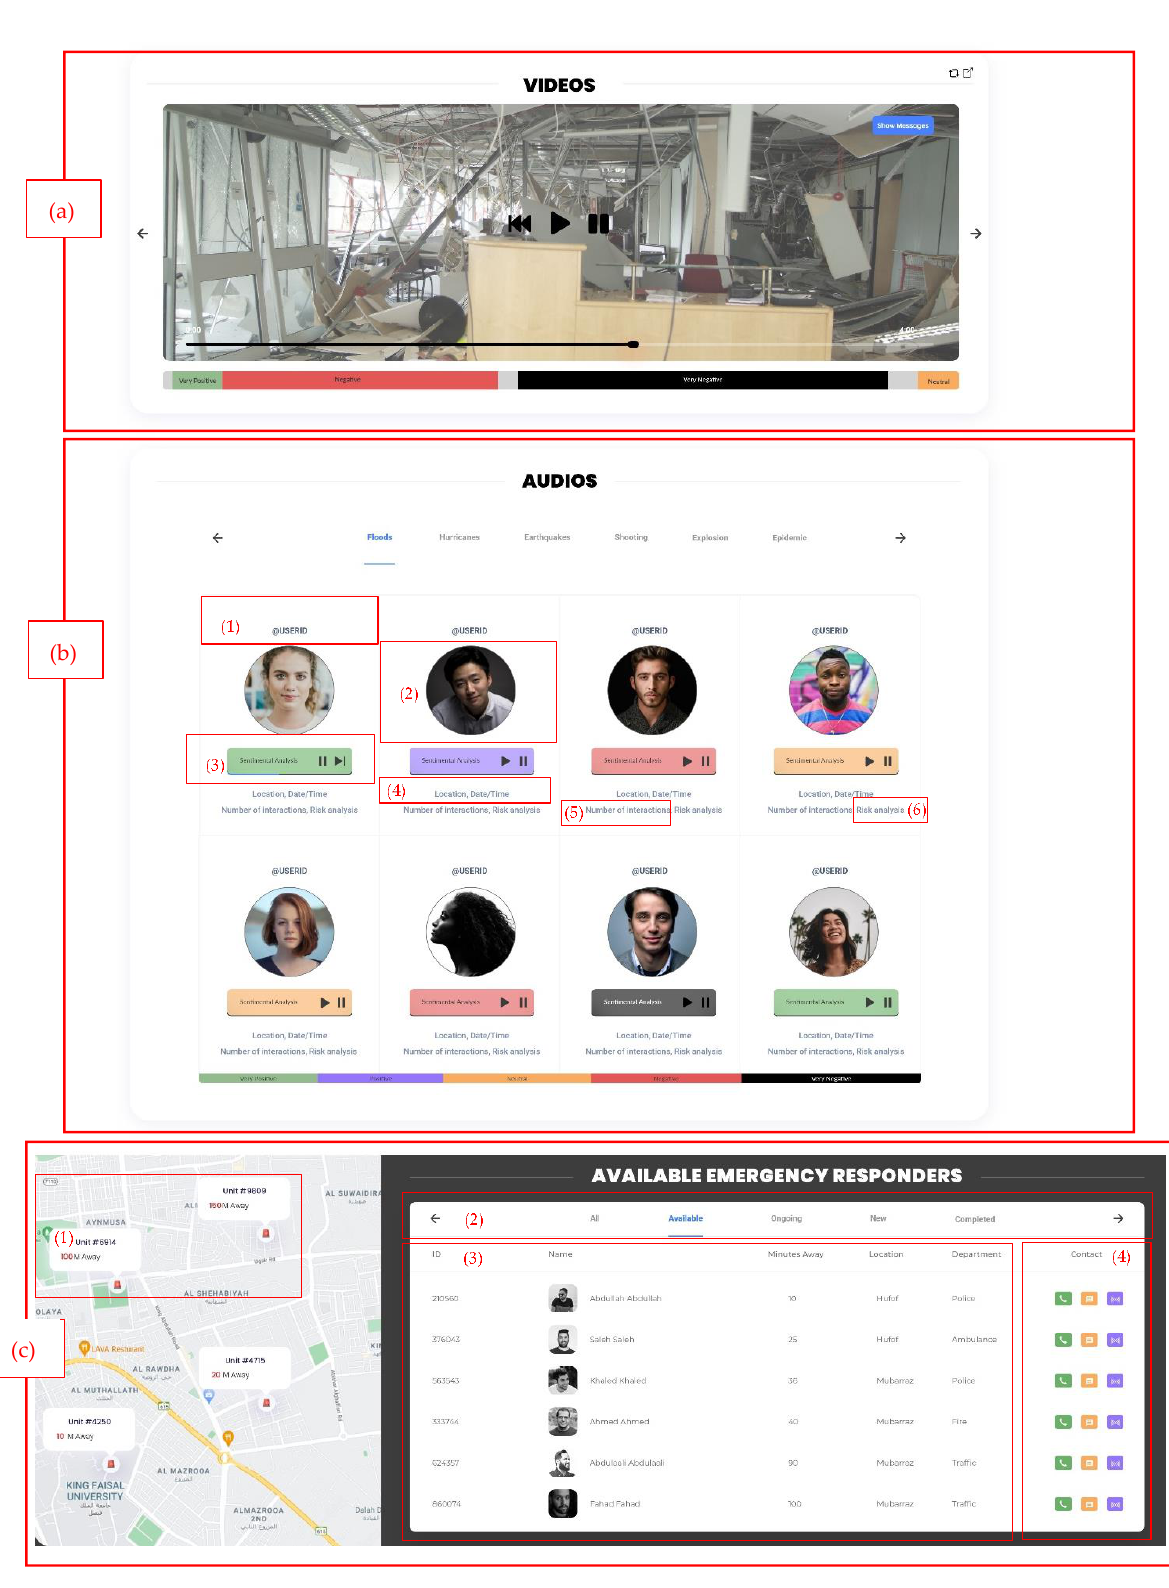
Figure 8. Multi-monitor visual analytics elements. ( a ) Video sentiment analysis. ( b ) audio map which includes: (1) username, (2) user display picture, (3) audio player, (4) metadata, (5) number of interactions, and (6) the risk analysis of the audio. ( c ) collaboration board that includes: (1) a map, (2) the board where the users can be categorized, (3) the emergency units’ information, and (4) the contact